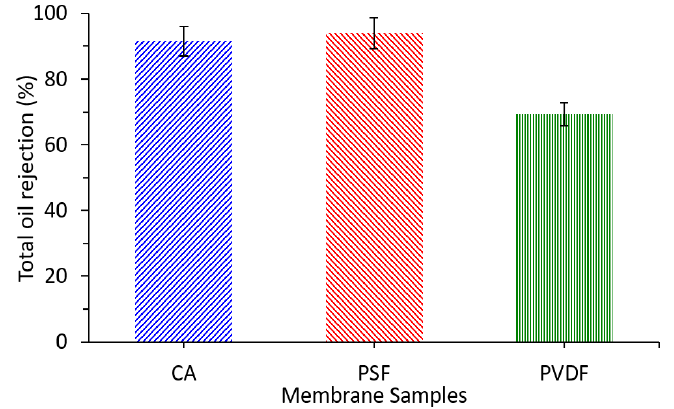
Figure 9. The oil rejection of PW filtration using the cellulose acetate (CA), polysulfone (PSF), and polyvinylidene difluoride (PVDF) membranes.